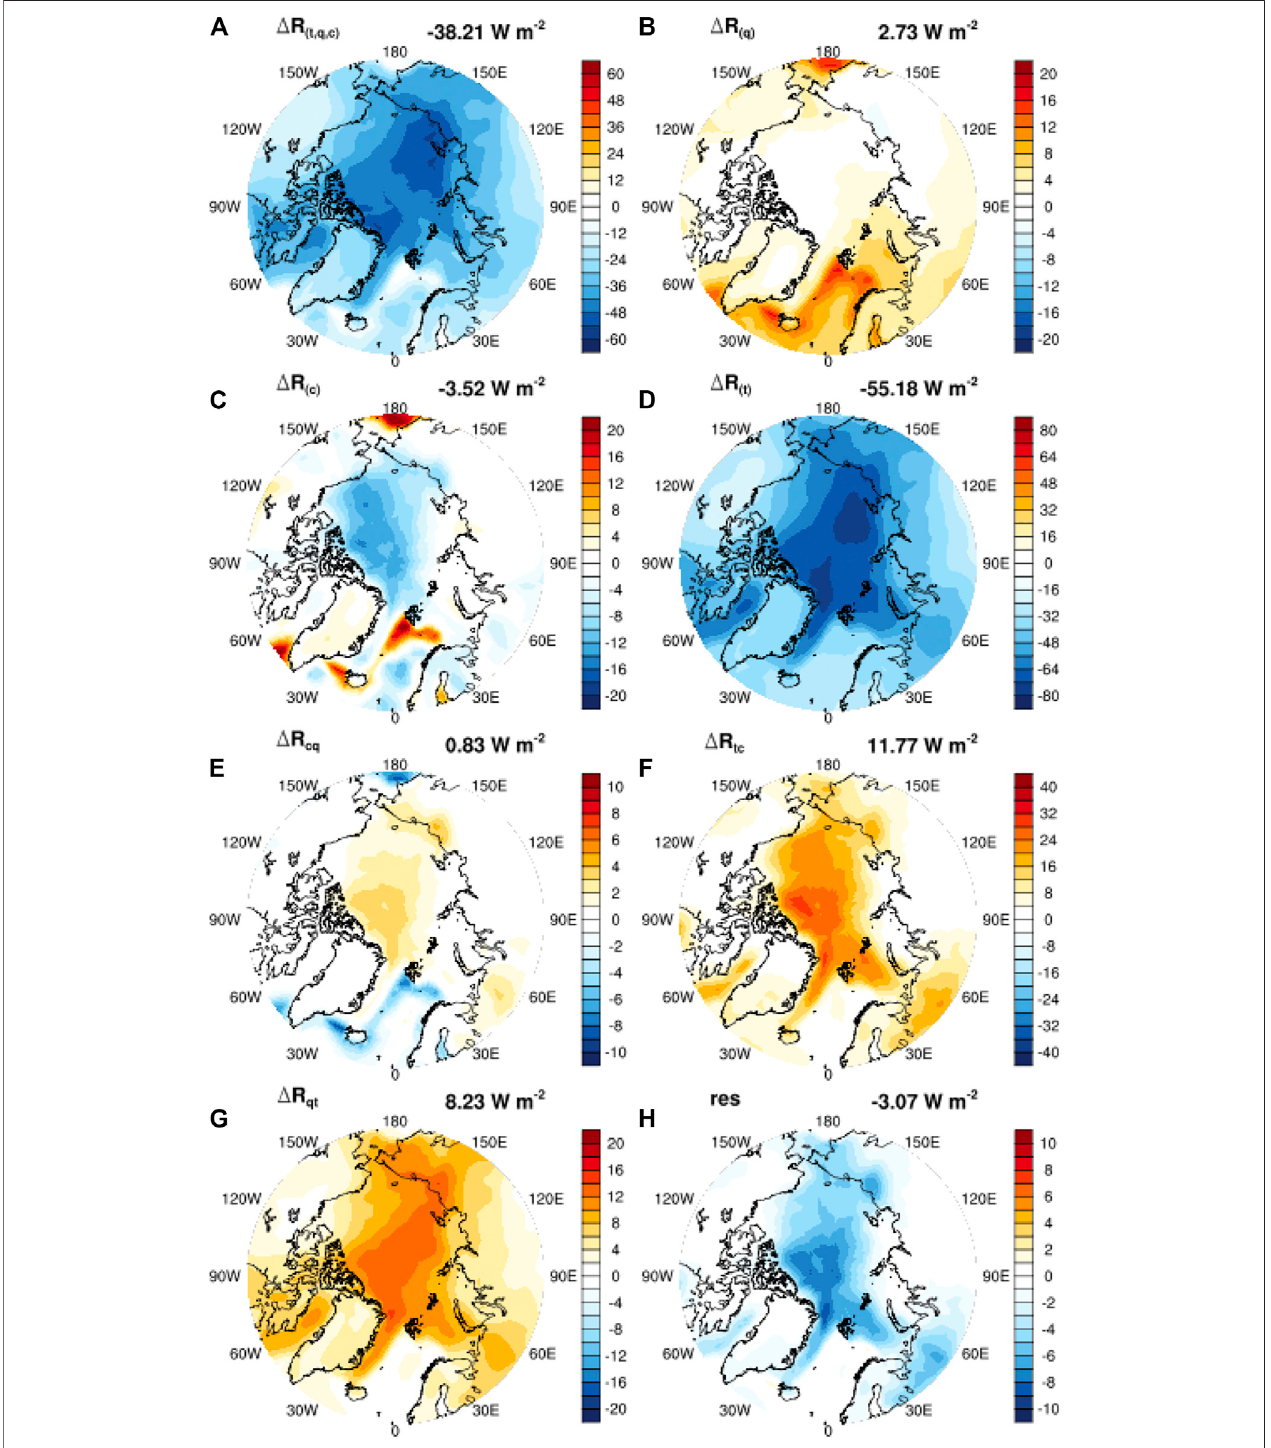
FIGURE 7 | All-sky LW feedback effects in January. Units: W m − 2 . Shown here are the total and component all-sky feedbacks in the 4xCO 2 experiment evaluated according to Eq. 2 , Eq. 3 , and Eq. 4 by using an RTM. t : atmospheric and surface temperatures; q : atmospheric water vapor; c : cloud; a : surface albedo; res: residual. The Arctic mean values are noted on the top right corner of each panel.